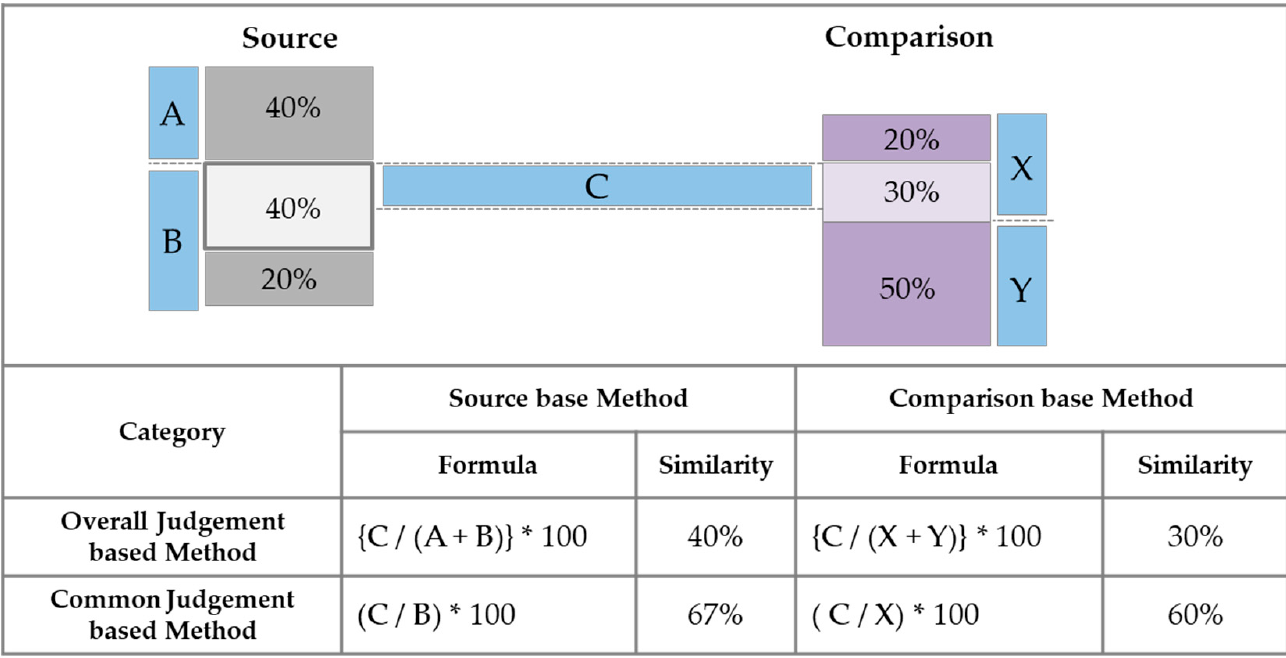
Figure 10. Source code similarity review method